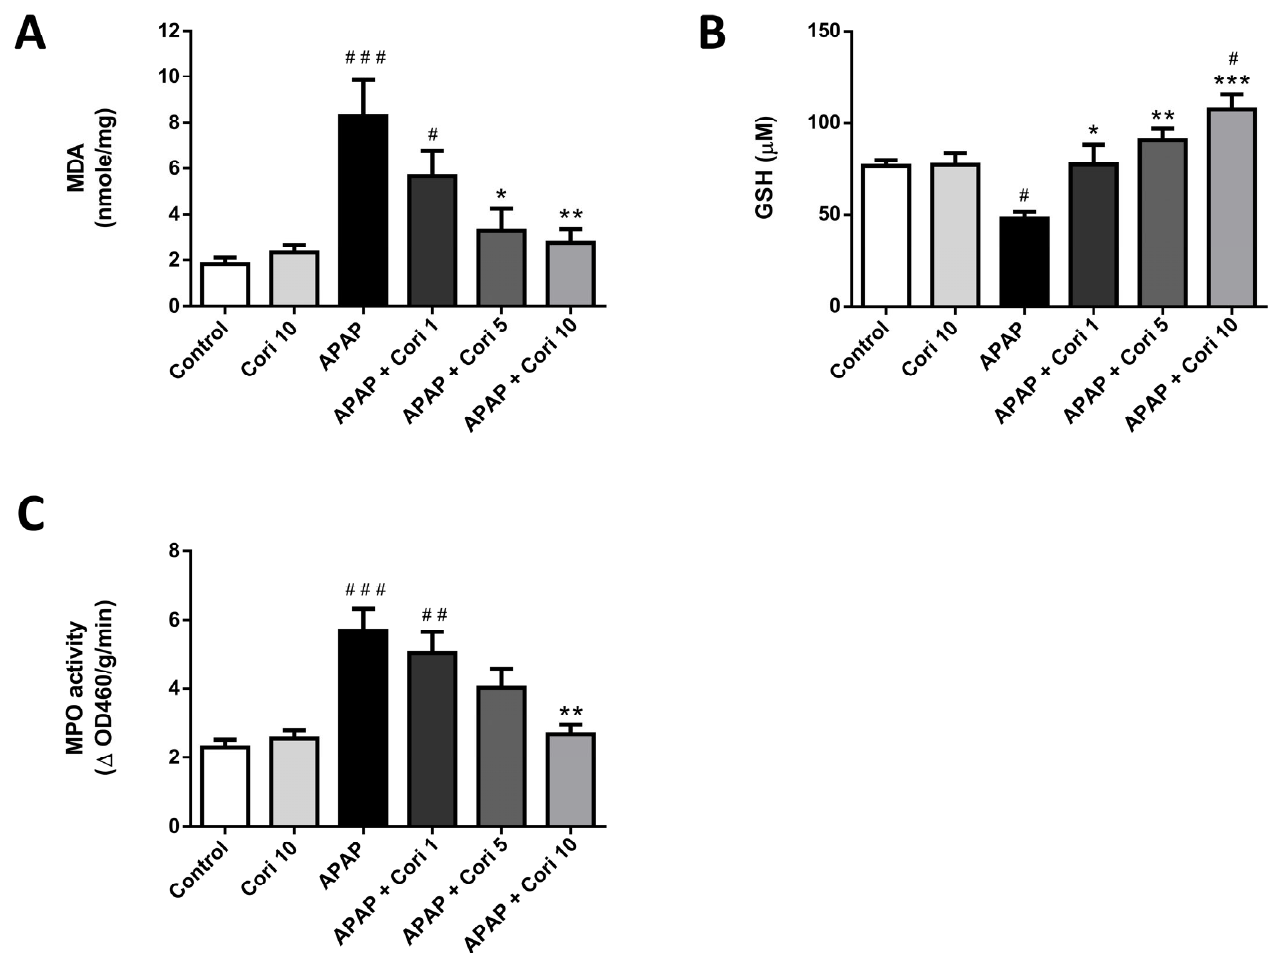
Figure 5. The effects of corilagin on MDA ( A ), GSH ( B ) levels, and MPO activity ( C ) in acetaminophen- induced hepatic injury. Animals were injected with APAP (300 mg/kg) or equal volume of saline (control), and treated with corilagin (0, 1, 5, or 10 g/kg). # p < 0.05, ## p < 0.01, ### p < 0.005 vs. control group; * p < 0.05, ** p < 0.01, *** p < 0.005 vs. APAP group.